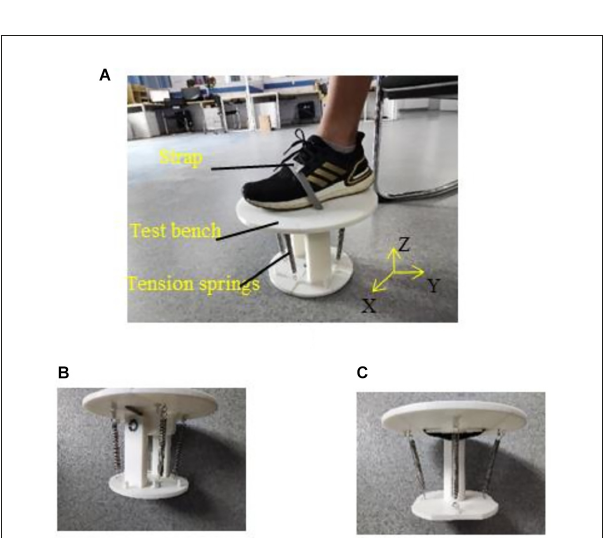
FIGURE3 Test benches. (A) Experimental setup. (B) Test bench of DF, PF, IV, and EV, the moving platform could rotate around the x -axis and y - axis. (C) Test bench of IR and ER, the moving platform could rotate around the z